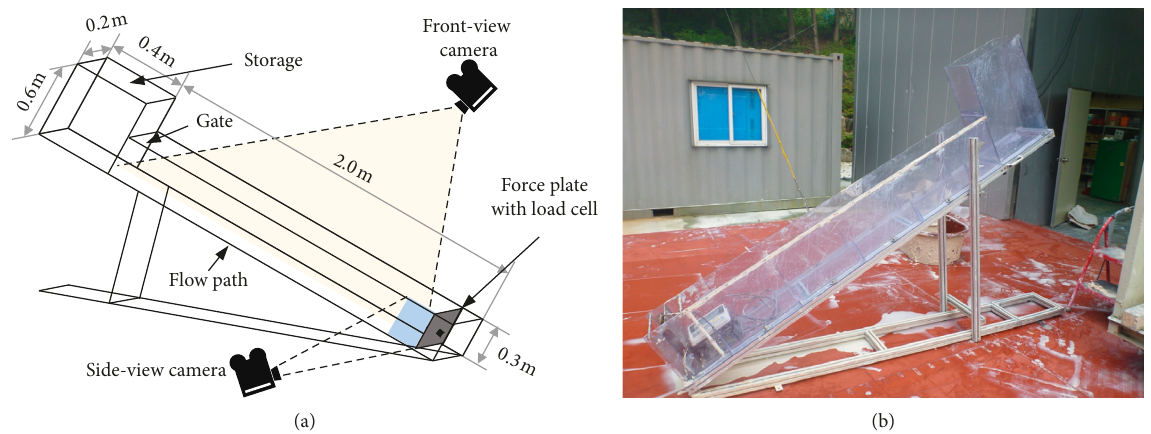
Figure 1: Schematic design (a) and photograph (b) of experimental flume and measuring Table 1: Overview of mean ( the standard error of the mean) sediment mixture properties. ±